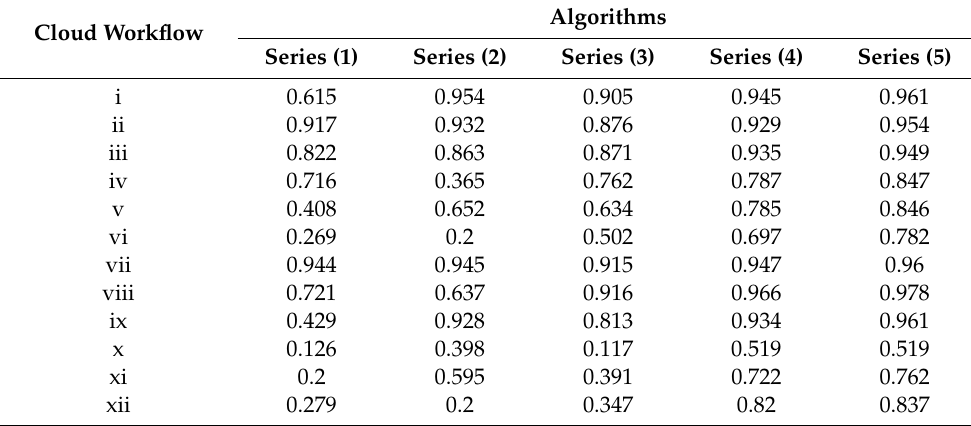
Table 1. Workflow comparative studies of existed